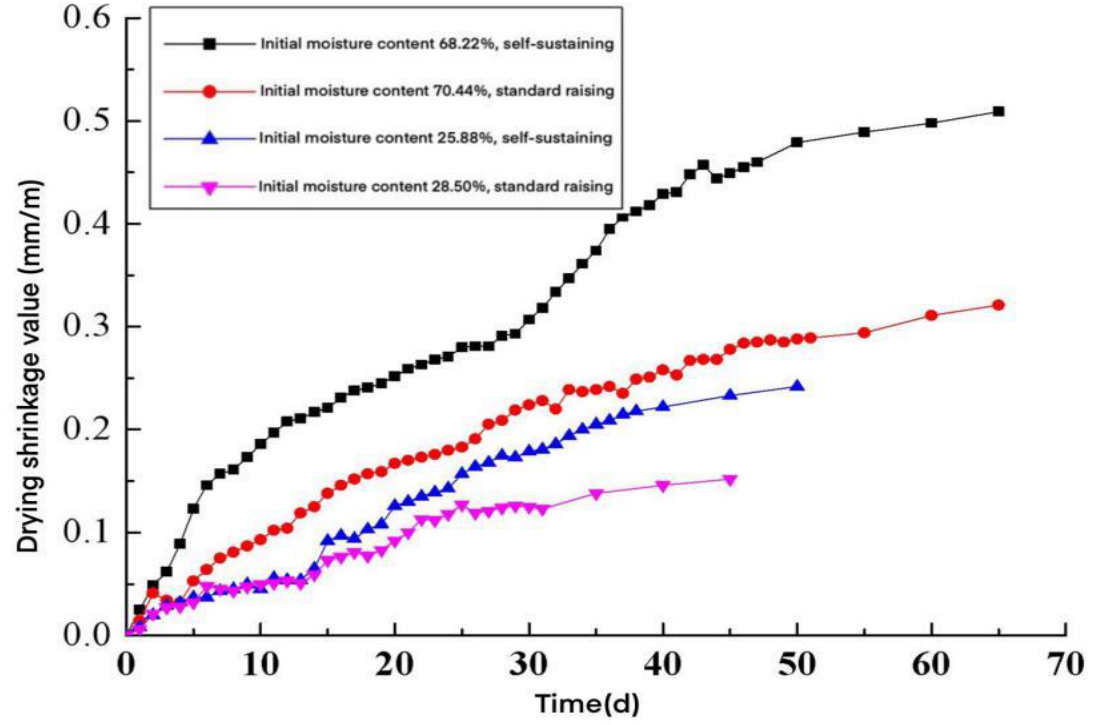
Figure 6. The curve of drying shrinkage value with time.